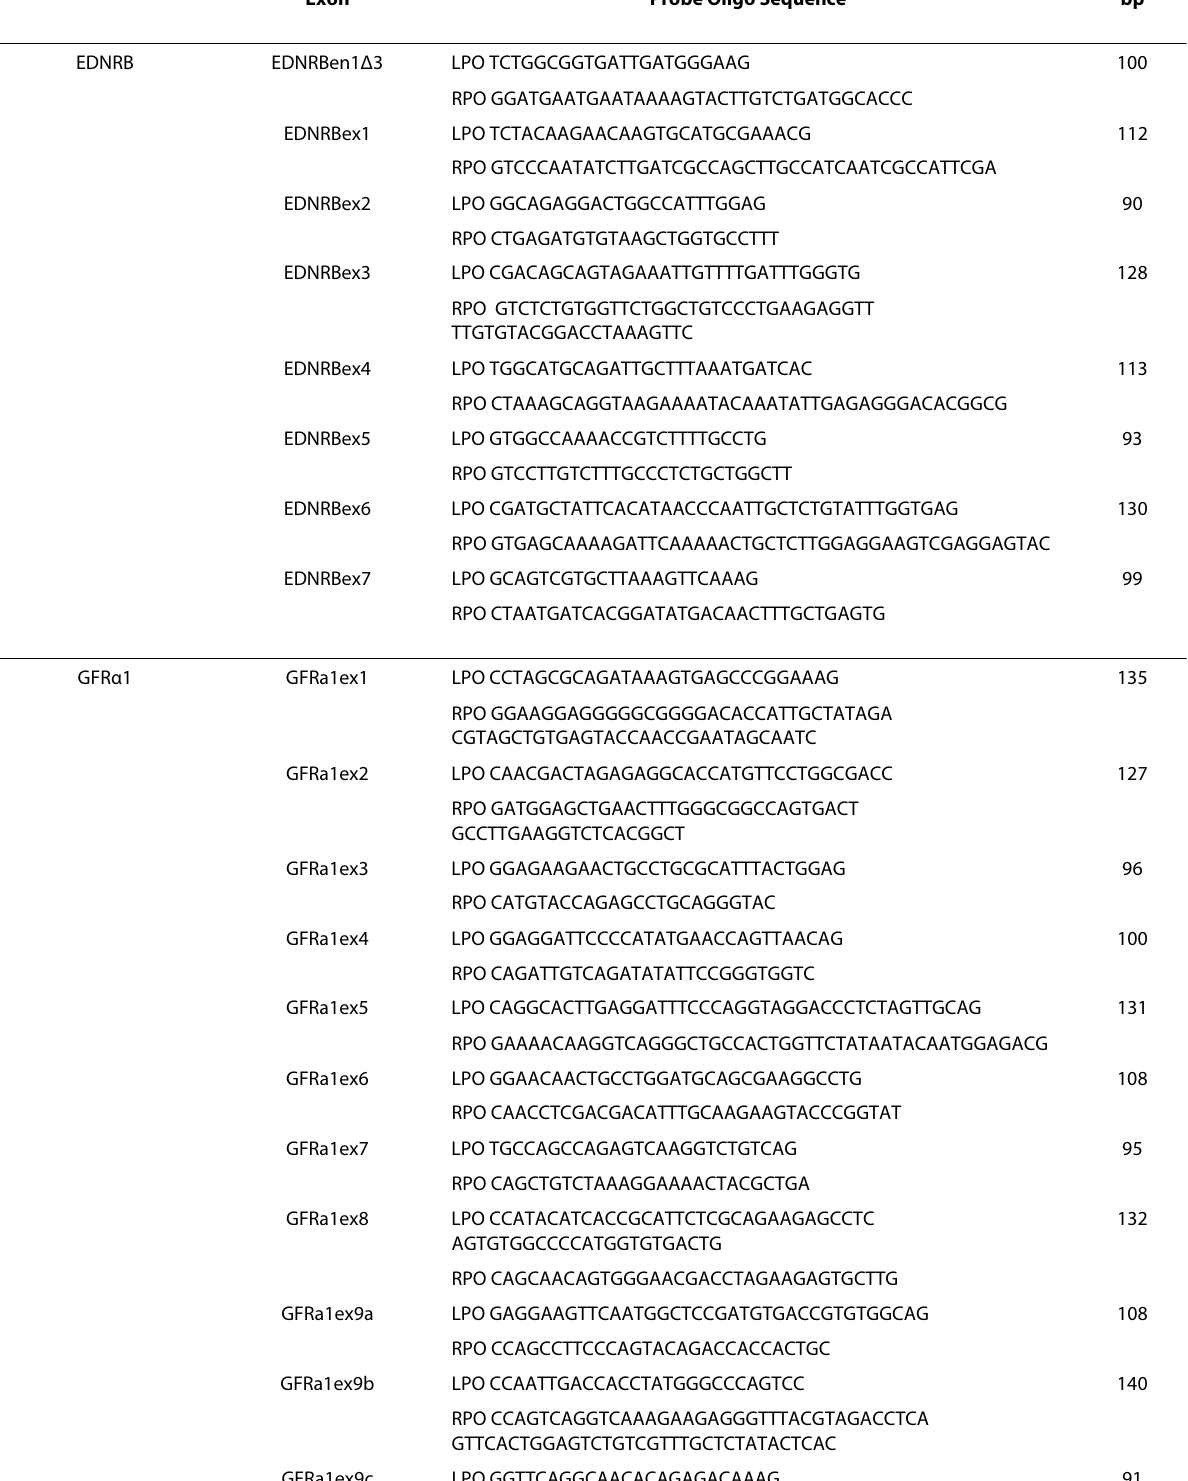
Table 1: Self-designed MLPA probes used in the molecular analysis of EDNRB, GFRa1, NRTN and PHOX2B CNVs of 208 HSCR